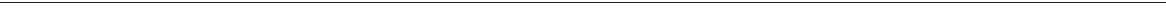
Fig. 3 IL-6-polarised M2 macrophages express CCL-20. a Heat map of differently expressed transcripts in tumours derived from 17-week-old HFD-fed Il6r α Fl versus Il6r α KO mice at day 62 of the 1.5% AOM/DSS protocol, assessed with a cutoff of a change in expression of 1.5-fold and p -value ≤ 0.025. b IPA analysis diagram of downregulated (green) and upregulated (red) cell recruitment factors in tumour tissues derived from 17-week-old HFD-fed Il6r α Fl versus Il6r α KO mice at day 62 of the 1.5% AOM/DSS protocol. Upper number represent respective p -value, lower number fold change. c qPCR analysis of indicated gene expression in tumours of 17-week-old HFD-fed Il6r α Fl versus Il6r α KO ( n = 6 – 12) at day 62 of the 1.5% AOM/DSS protocol, results are presented relative to non-colitic NCD Il6r α Fl colons at day 0. d qPCR analysis of indicated gene expression in distal colons of 8-week-old NCD ( n = 6) and HFD ( n = 7) fed C57BL/6 mice. e qPCR analysis of Ccl20 expression in non-tumour tissue and tumours of 17-week-old NCD and HFD-fed Il6r α Fl and Il6r α KO mice ( n = 6) at day 62 of the 1.5% AOM/DSS protocol, results are presented relative to NCD Il6r α Fl non-tumour at day 62. f Representative immuno fl uorescent stainings of CCL-20 (red) expression in colons of 17-week-old NCD and HFD-fed Il6r α Fl and Il6r α KO mice at day 62 of the 1.5% AOM/ DSS protocol. g qPCR analysis of Ccr6 expression in non-tumour tissue and tumours of 17-week-old NCD and HFD-fed Il6r α Fl and Il6r α KO mice ( n = 6) at day 62 of the 1.5% AOM/DSS protocol, results are presented relative to NCD Il6r α Fl non-tumour at day 62. h qPCR analysis of Ccl20 gene expression in F4/80 MACS-puri fi ed macrophages from colitic colons of 10-week-old NCD-fed Il6r α Fl , Il6r α KO and Il6r α myl - KO ( n = 6) at day 13 of the 1.5% AOM/DSS protocol, results are presented relative to macrophages F4/80 MACS sorted from non-colitic Il6r α Fl colons. i CCL-20 produced by M1- and M2-polarised BMDM from control mice ( n = 4) stimulated 24 h with IL-6 or LPS as examined by ELISA. qPCR analysis of Ccl20 gene expression in j M1 ( n = 4 – 15) or k M2 ( n = 7)-polarised BMDM stimulated with IL-6 or LPS for 8 h from Il6r α Fl and Il6r α KO mice, results are presented relative to LPS-stimulated Il6r α Fl M1. l CCL-20 produced by M2-polarised BMDM stimulated 36 h with LPS from Il6r α Fl and Il6r α KO mice ( n = 6) as examined by ELISA. AOM, azoxymethane; DSS, dextran sodium sulphate; NCD, normal chow diet; HFD, high-fat diet; IPA, Ingenuity pathway analysis; MACS, magnetic-activated cell sorting; BMDM, bone marrow-derived macrophages; n.d., not determined. centre line: median; box limits: 1st and 3rd quartiles; whisker: maximum to minimum, * p ≤ 0.05, ** p ≤ 0.01 and *** p ≤ 0.001 two-tailed unpaired Student ’ s t -test d , one-way h or two-way ANOVA followed by Fisher LSD c , e , g , i , j , k , l . Scale bar, 50 μ